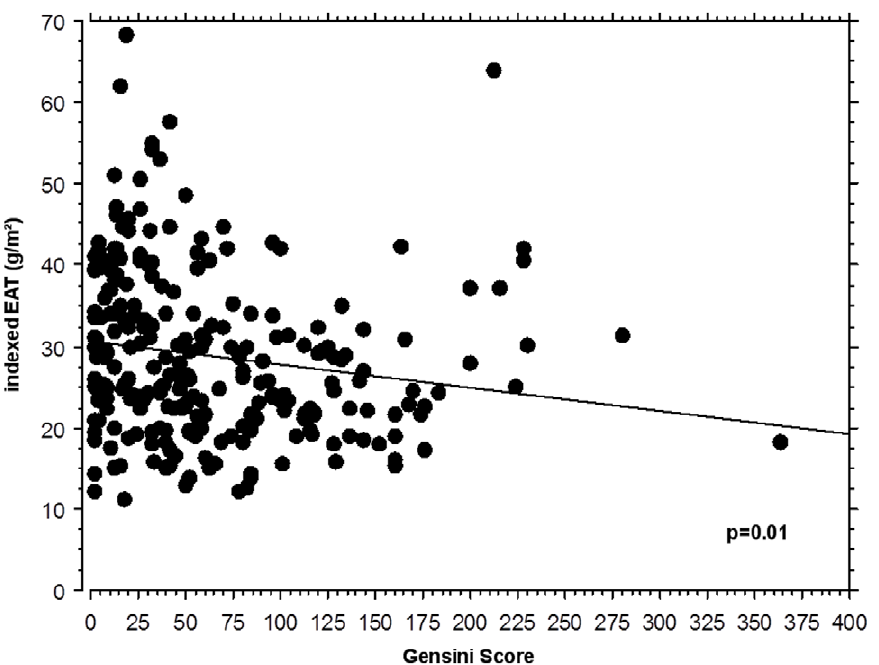
Figure 1. Correlation between EAT and atherosclerosis severity in all CAD patients. The linear regression analysis in all CAD patients revealed a significant correlation between indexed EAT mass and the severity of atherosclerosis as assessed by the angiographic GSS (Pearson correlation coefficient r=0.177, associated p-value=0.01). Abbreviations: CAD: coronary artery disease, EAT: epicardial adipose tissue, GSS: Gensini score.